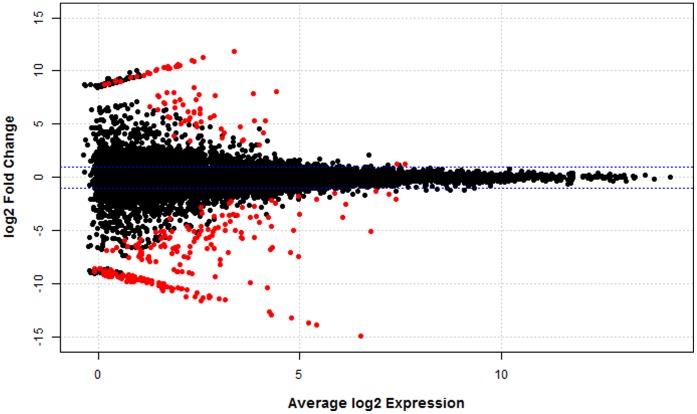
Plot of the log2 fold change against average log2 expression.Gene expression was expressed as counts per million. Horizontal blue lines indicate 2-fold change. Differential expressed genes (FDR <0.10) are highlighted in red.